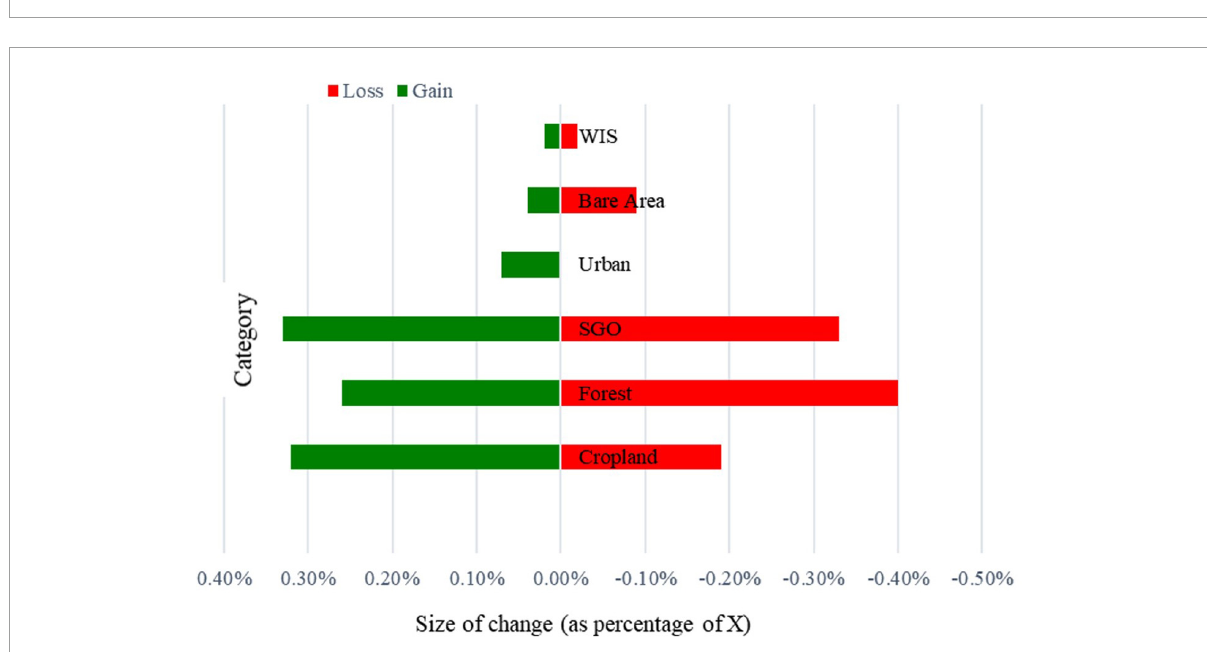
FIGURE5 The losses and gains for each land-cover type during the entire study period.